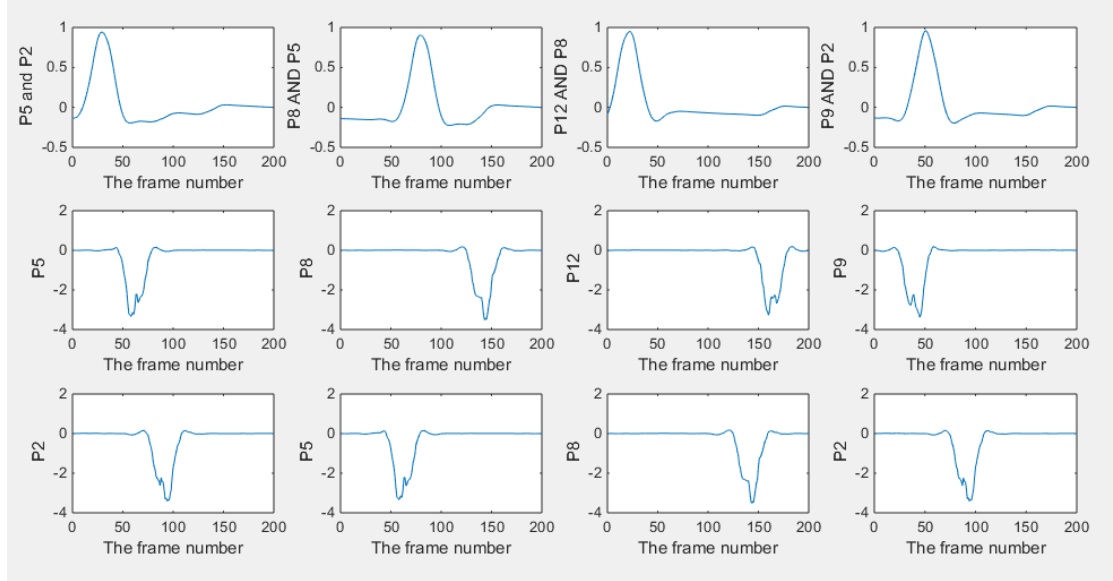
Figure 4. Plots of cross-correlation results and the corresponding pixels in the 2D simulation test: